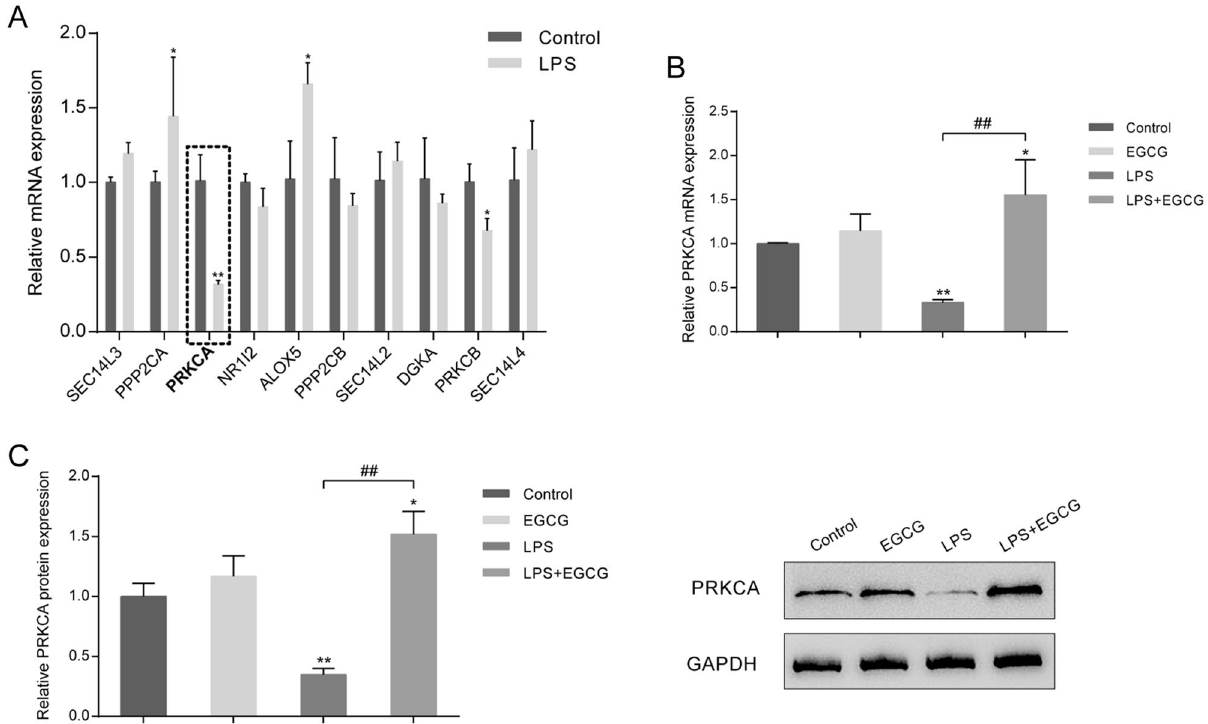
Figure 3. EGCG modulates PRKCA expression in LPS-induced ALI mice. Mice were divided into four groups (the control group, the EGCG group, the LPS group, and the LPS + EGCG group) accordingly. ( A ) The expression levels of the top ten genes predicted to interact with EGCG were examined in the control group and the LPS group using real-time qPCR. ( B ) PRKCA mRNA expression in mouse lung tissues from each group was determined using real-time qPCR. ( C ) PRKCA protein levels in mouse lung tissues from each group were determined using Immunoblotting. * P < 0.05, ** P < 0.01 compared to Control group; ## P < 0.01 compared to LPS